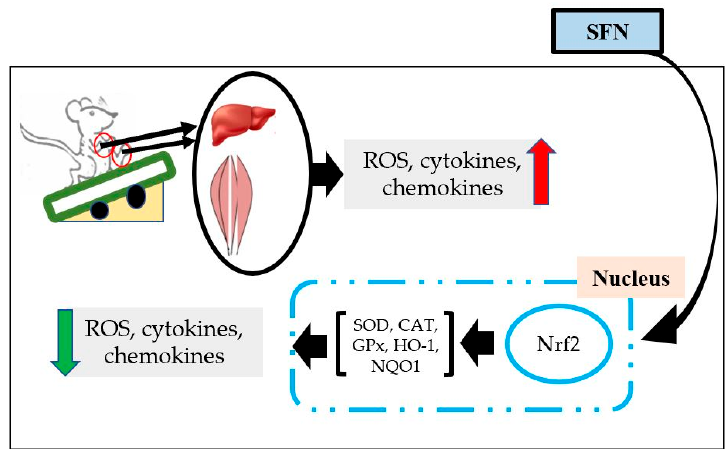
Figure 2. The organ protective effect of SFN after exercise. Acute exhaustive exercise increases the production of reactive oxygen species (ROS), cytokines, and chemokines in liver and muscles. SFN treatment activates Nrf2, which translocates into the nucleus to induce production of cellular defense enzymes, such as superoxide dismutase (SOD), catalase (CAT), glutathione peroxidase (GPx), heme oxygenase (HO) 1, NADPH quinone oxidoreductase (NQO) 1, etc. Therefore, SFN reduces ROS, cytokines, and chemokines expression.